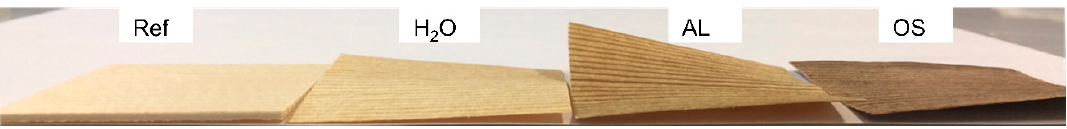
Figure 2. Representative photographs of single veneers in untreated condition (Ref), densified after soaking with water (H 2 O), densified after alkali-delignification (AL), and densified after organosolv delignification (OS).